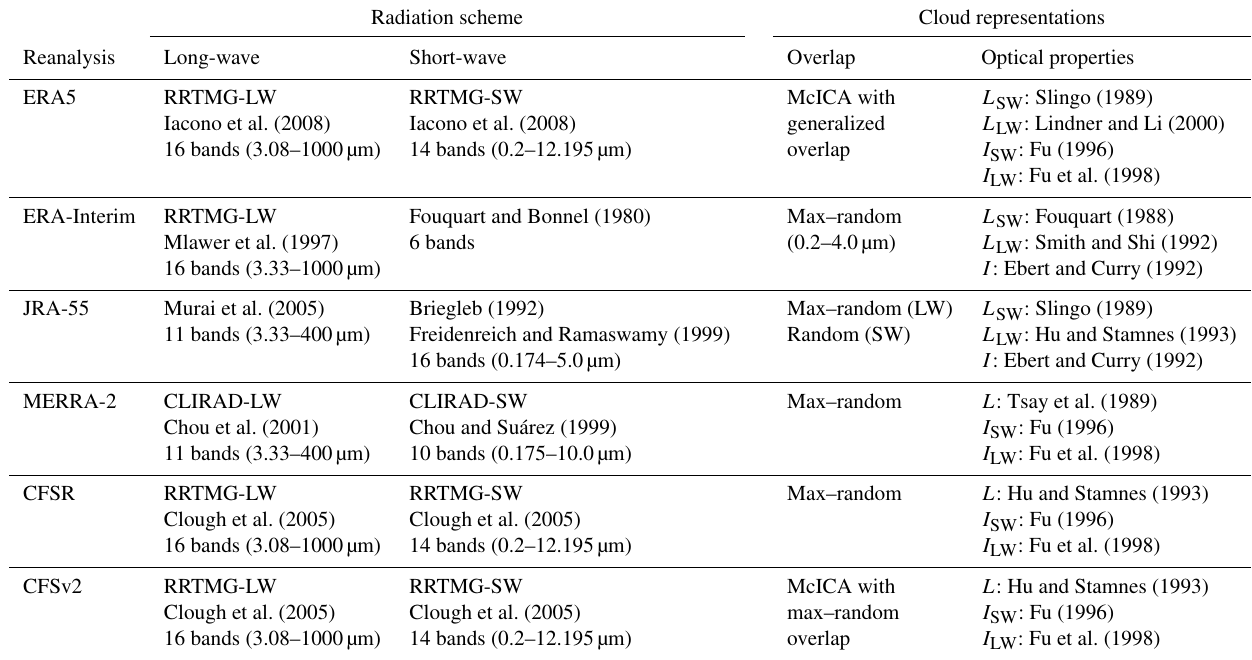
Table B1. Summary information on radiation parameterizations, cloud overlap, and cloud optical properties used in the reanalyses. In the column labelled “Optical properties”, L stands for liquid water clouds and I for ice clouds. Sources of cloud optical properties may differ between the LW and SW schemes. RRTMG: Rapid Radiative Transfer Model.